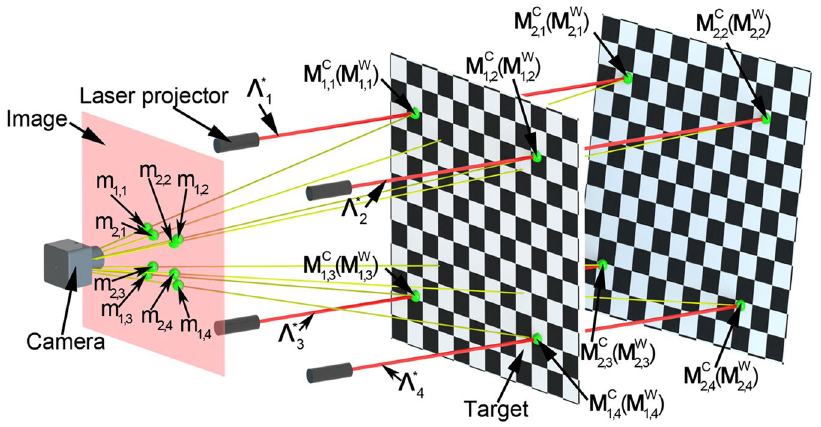
Figure 1. Calibration method of the laser lines with the intersection points in the camera coordinate system. The measurement system consists of four laser projectors and a camera. The positions of the projectors are fixed relative to the camera. A planar target is employed as the reference of the calibrations for the camera and laser